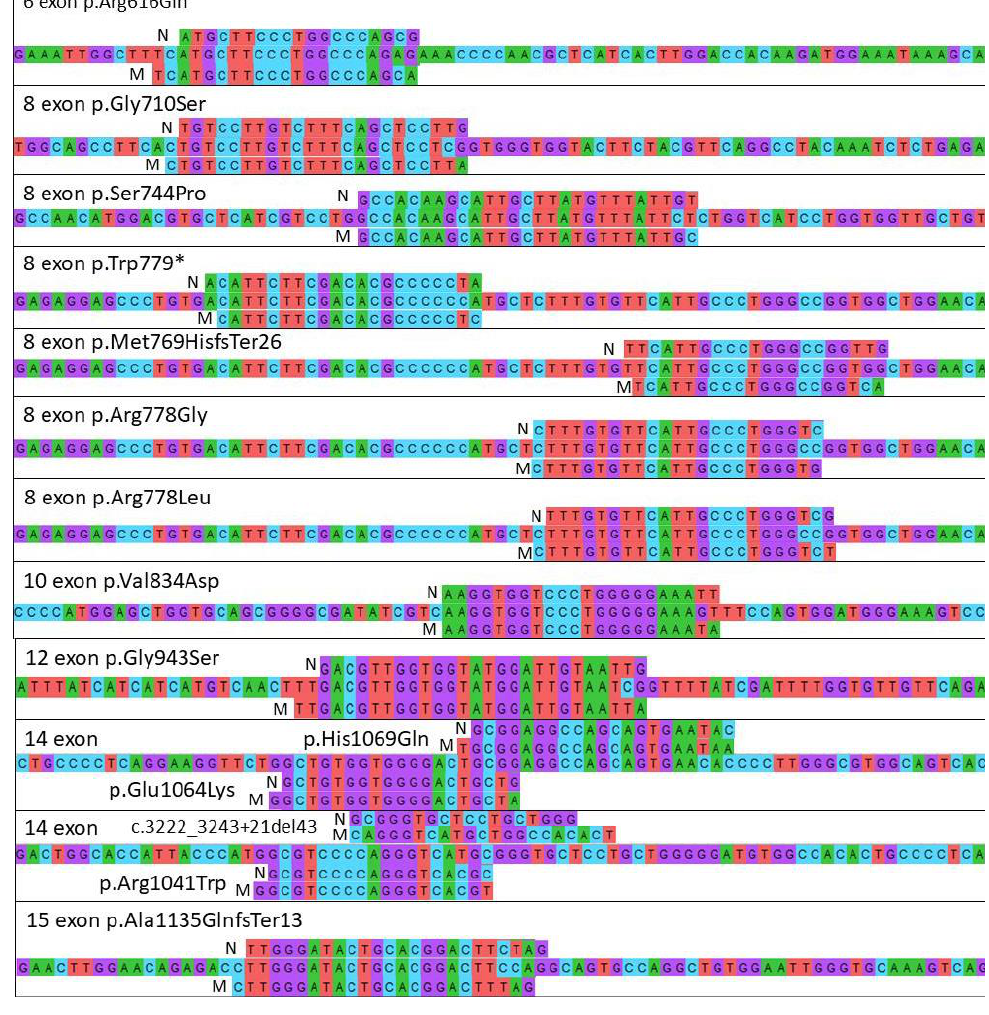
Figure 2. The location of primers for searching for mutations in different exons of the ATP7B gene, where N is the primer with the normal allele and M is the primer with the mutant allele.